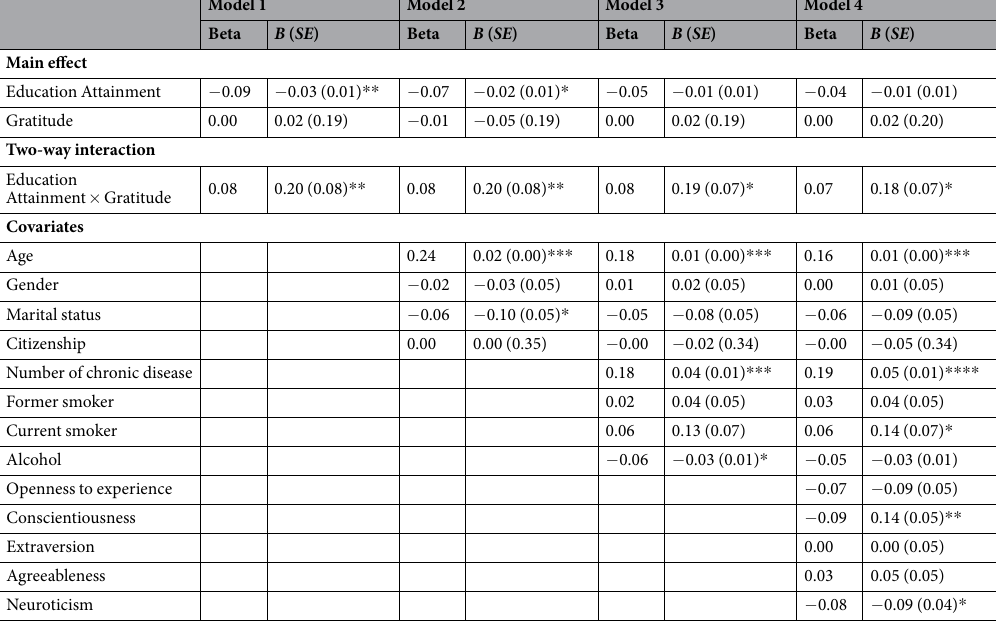
Table 1. Model Summaries of Interleukin-6 with Education Attainment and Dispositional Gratitude as Predictors. Note : Gender was dummy coded with female as reference. Marital status was dummy coded